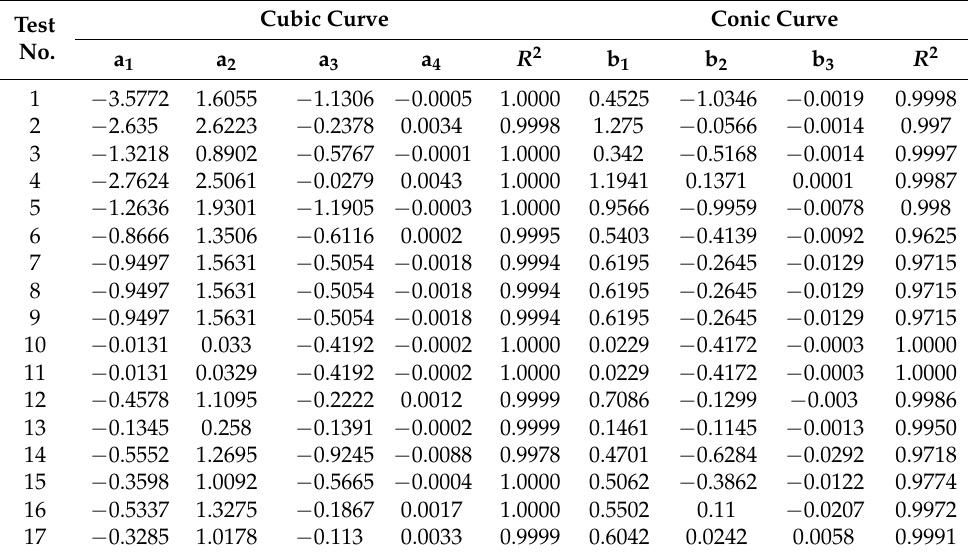
Table 6. Simulation results of Box–Behnken test.